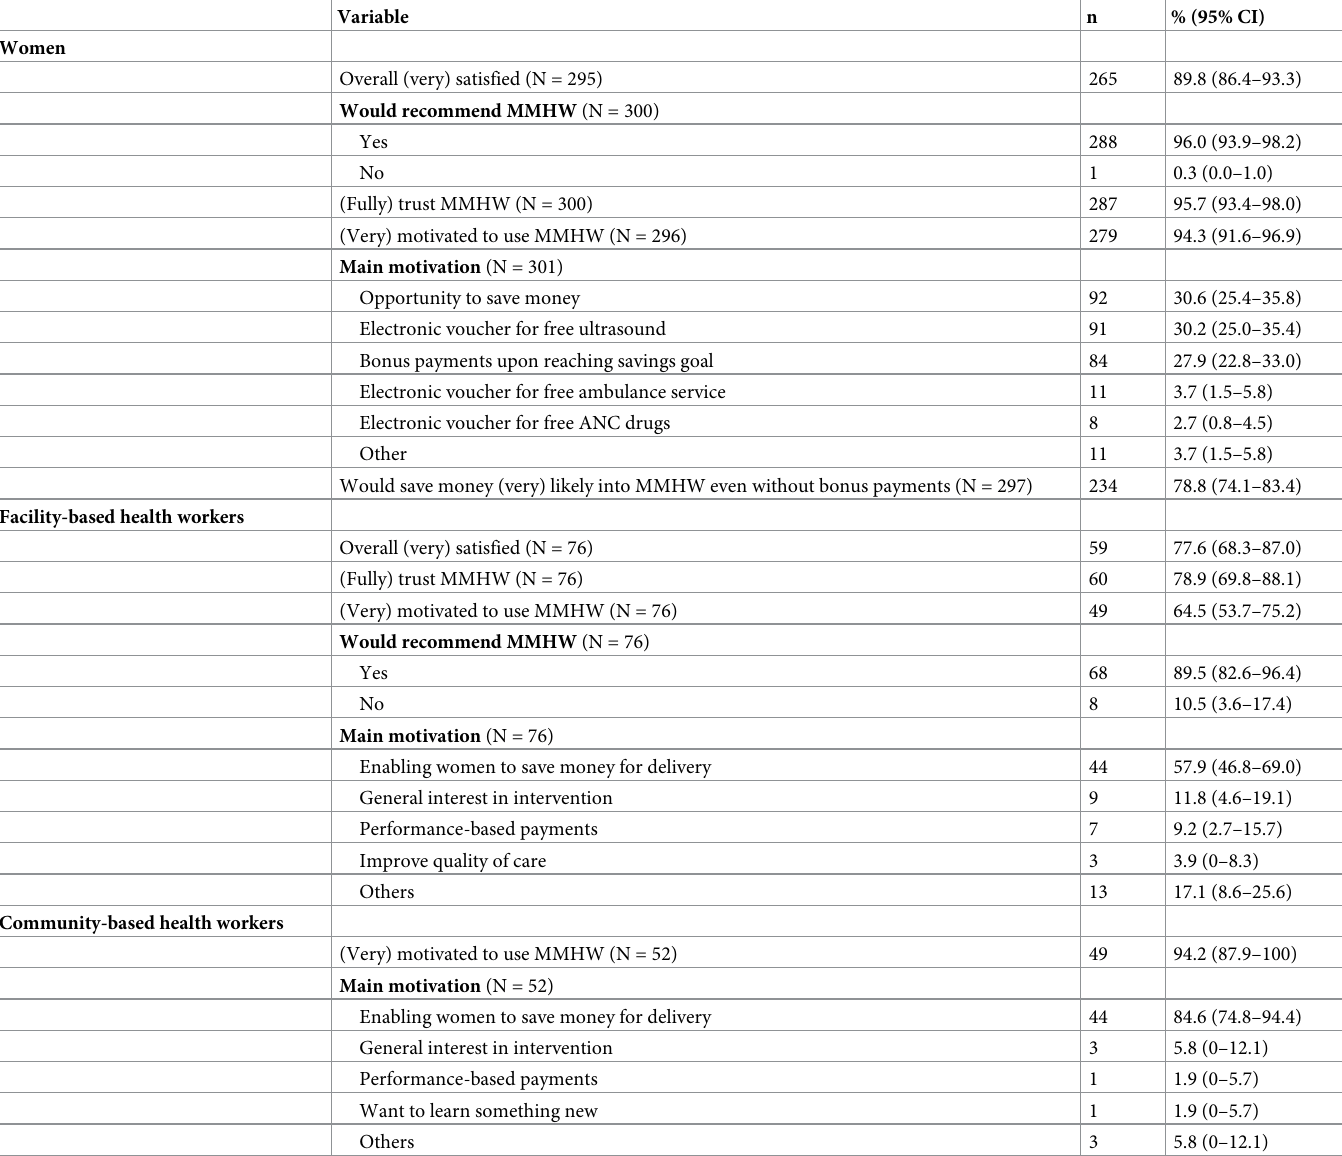
Table 3. Experiential and motivational characteristics to use the MMHW among women, facility- and community-based health